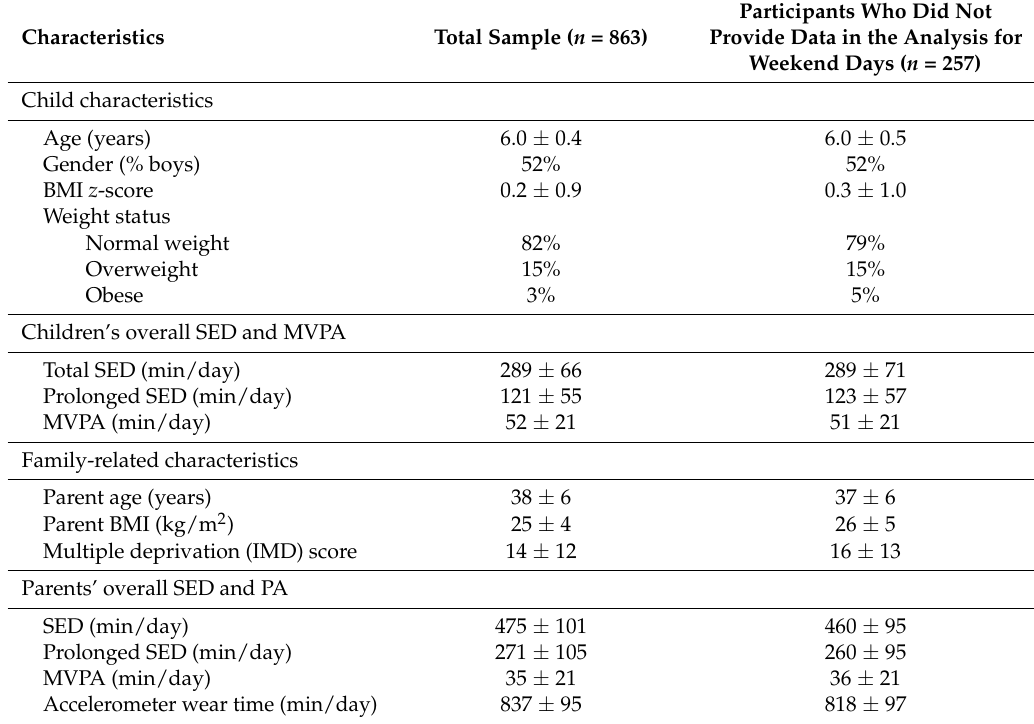
Table A2. Main child- and family-related characteristics of children included in the total sample and children who did not provide data in the subsample for weekend